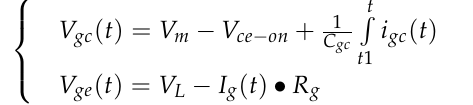
Dynamic Voltage Feedback